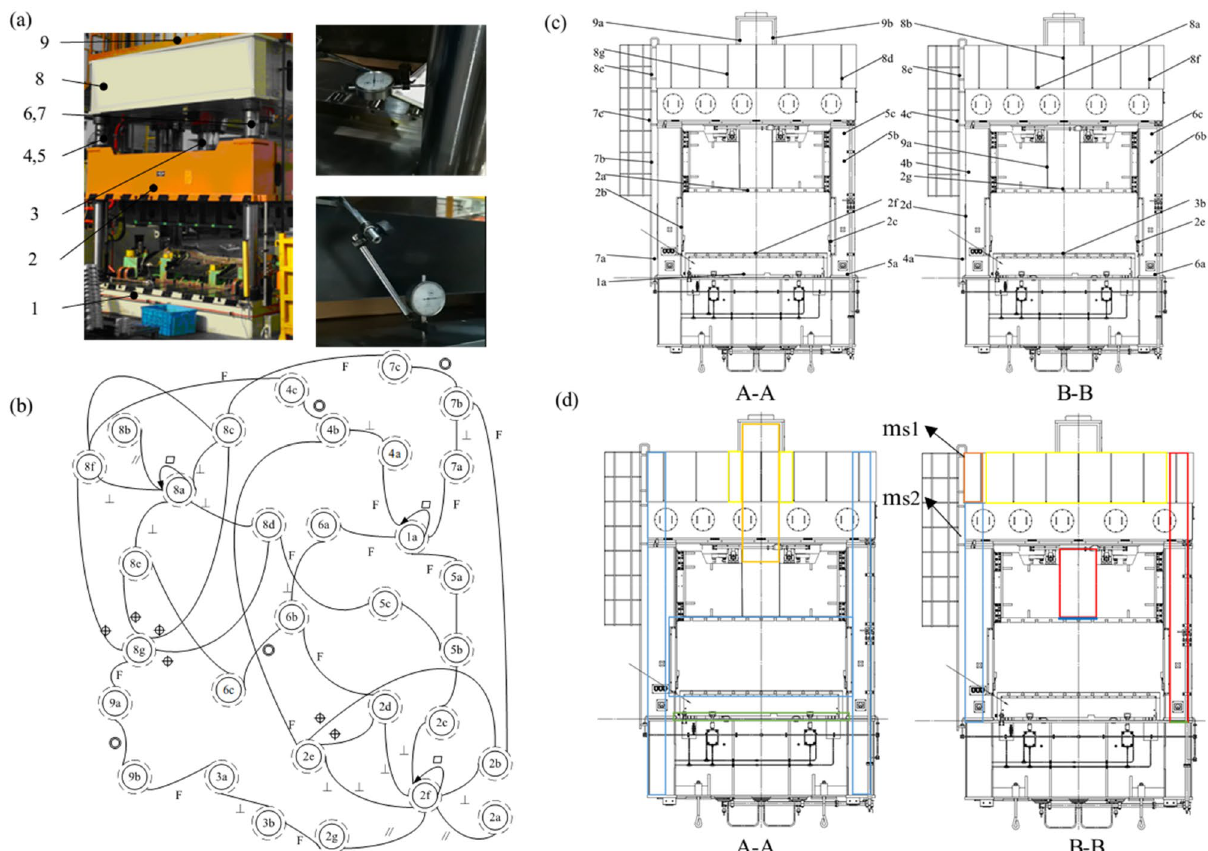
Figure 8. Case study: ( a ) Schematic diagram of the four-column hydraulic press to be repaired and the deviation collection on site, ( b ) feature graph of four-column hydraulic equipment, ( c ) simplified three- dimensional hydraulic equipment assembly and node definition, ( d ) all node labels of four-column hydraulic press represented in 5